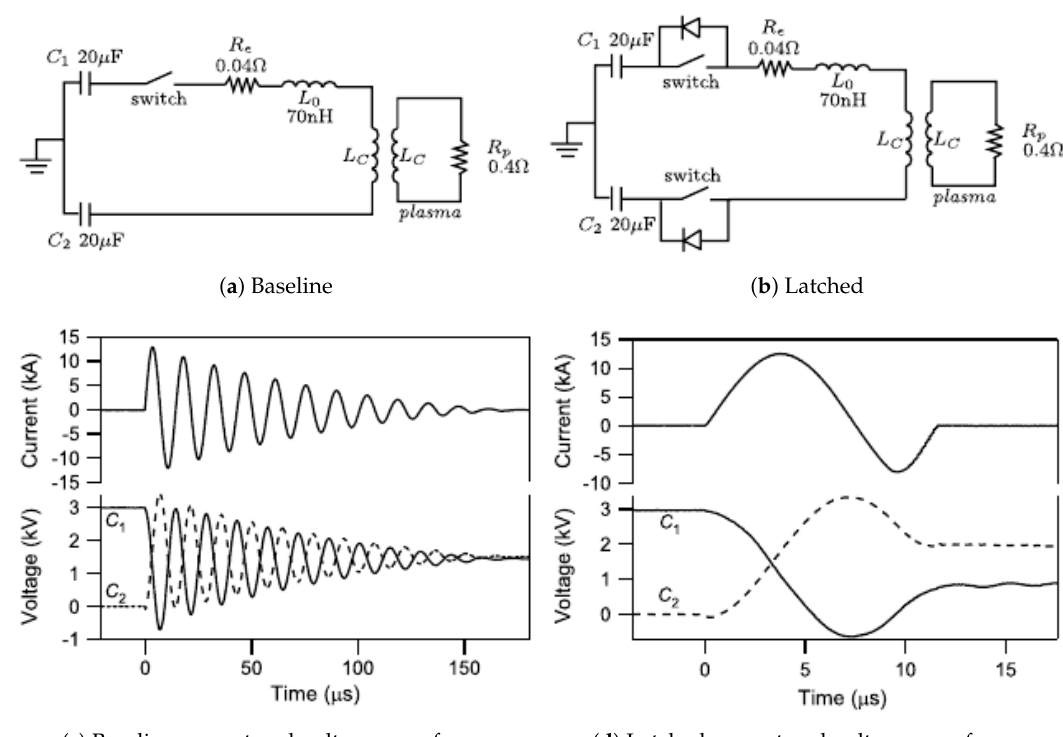
Figure 24. Bernardes and Merryman discharge circuit schematics for ( a ) baseline and ( b ) diode-latched configurations. Current and voltage waveforms for capacitors C 1 and C 2 in the ( c ) baseline and ( d ) diode-latched configurations (from